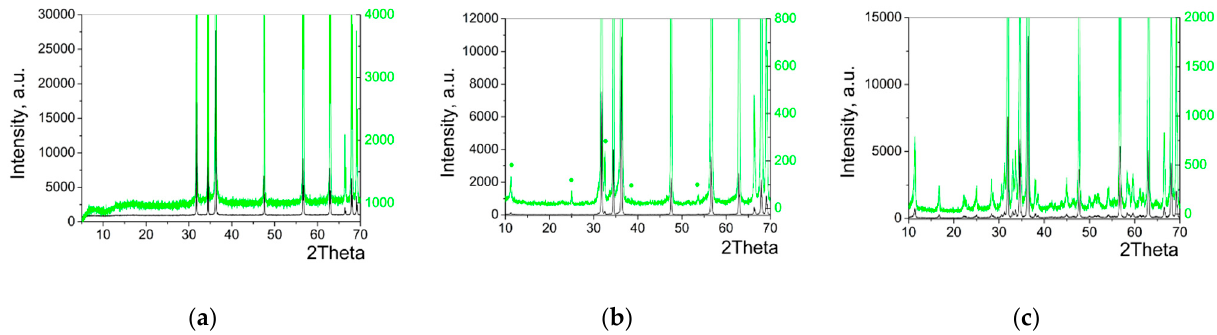
Figure 7. X-ray patterns of samples: ( a ) CSP1; ( b ) CSP4; ( c ) TVT4: black—full spectrum; green—the spectrum is shown with increased sensitivity for the low-intensity reflexes detection; green dots—reflexes of unidentified phase.